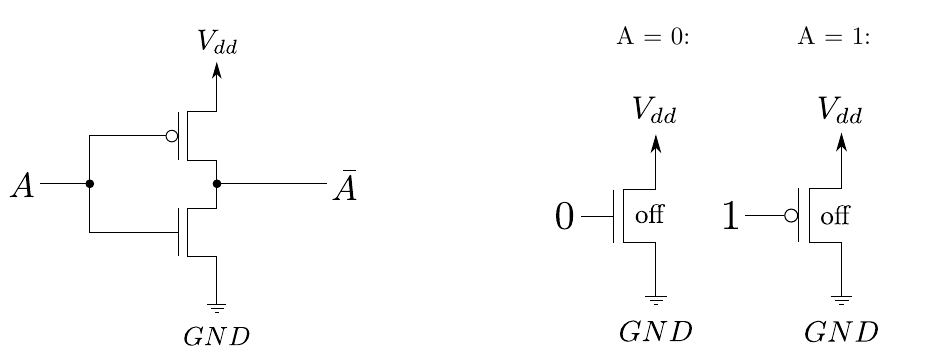
Figure 2: CMOS NOT (or inverter) gate (left) and formation of inactive transistors across the power supply path for different inputs (right), assuming perfect conduction for active transistors.